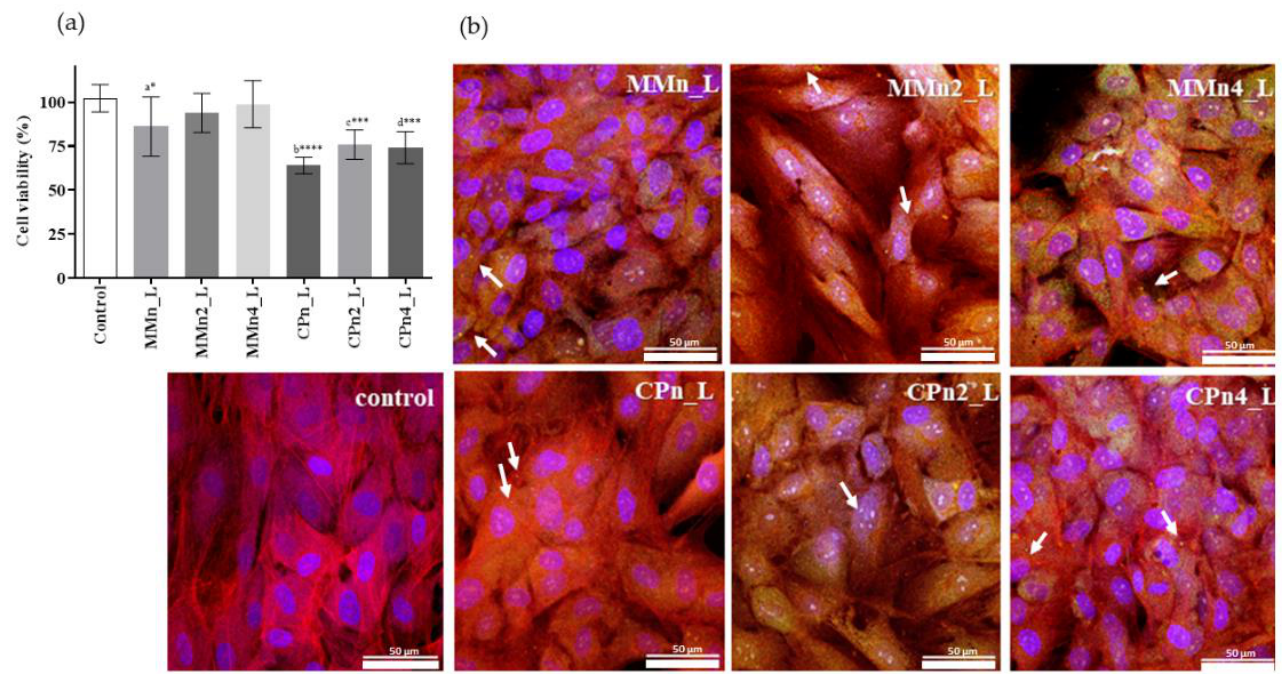
Figure 7. ( a ) Cell viability (%) using 3T3 in contact with nano-hybrid systems (0.5 µg mL −1 of lipid MM or CP) with and without AO at 2 and 4%, diluted to 0.1 and 0.2 µg mL −1 , respectively, in com- parison to the positive control GM (growth medium, as standard growth conditions) (means ± SD, n = 8). Statistical analyses: a*. Control vs. MMn_L, b**** = control vs. CPn_L, c*** = control vs. CPn2_L, and d*** control vs. CPn4_L, **** p < 0.0001, *** p < 0.001, * p < 0.05, (ANOVA and Turkey– Kramer test, 95% confidence level). ( b ) Confocal images (objective 63×); type of cell: nHDFs; Hoechst: nuclei; Phalloidin-TRIC: Actin; sample ( ʎ ex = 405 nm– ʎ em = 460 nm); sample dilution 1:200; 48 h cell-sample contact. Abbreviations: nHDFs, normal human dermal fibroblasts.